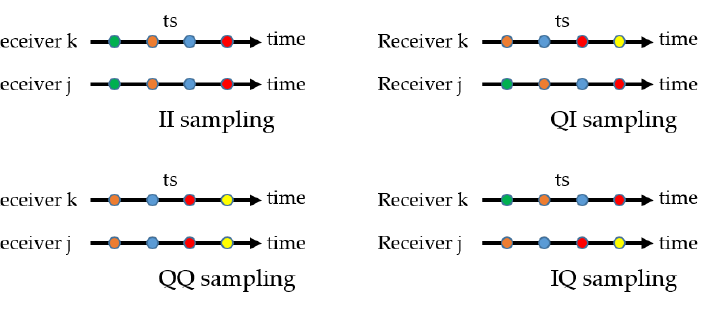
Figure 2. Sampling strategy to measure the four real correlation products. Each color represents a complete and consistent set for a given snapshot and t s is the sampling period. Note that, for example, the II measurement of the blue snapshot is the same as the QQ of the red snapshot. In this drawing, green and yellow snapshots are not